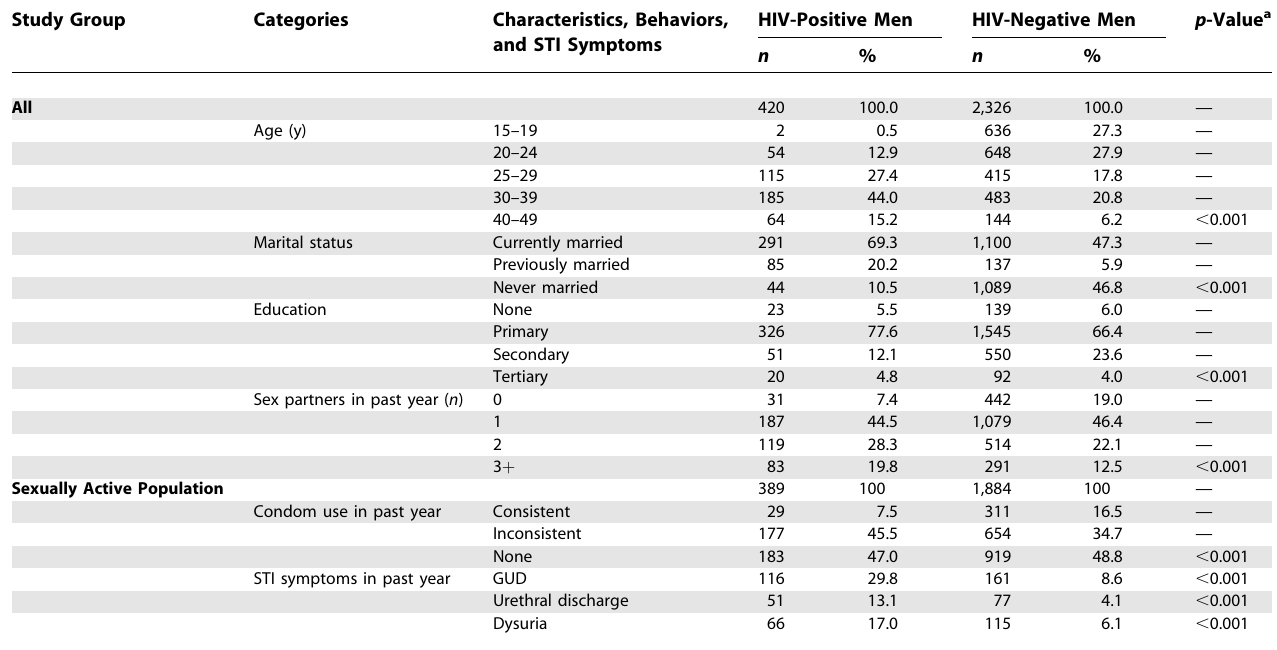
Table 1. Characteristics of HIV-Positive and HIV-Negative Men Study Group Categories Characteristics, Behaviors,